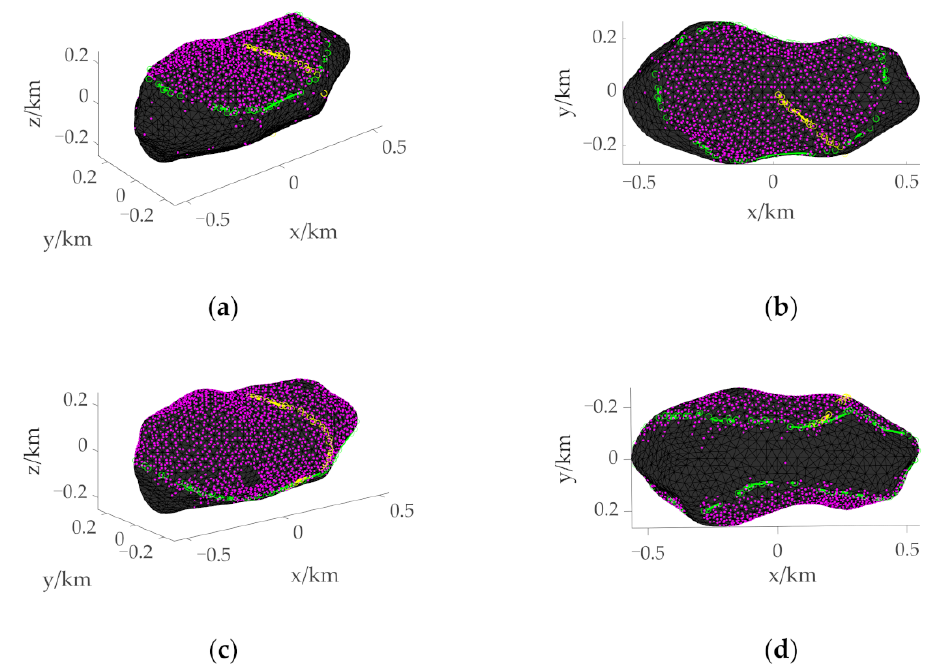
Figure 8. Initial boundary when the initial position is above the North Pole. ( a ) 3D view of the initial boundary with t f = 900 s. ( b ) Supplementary view of the initial boundary with t f = 900 s. ( c ) 3D view of the initial boundary with t f = 1000 s. ( d ) Supplementary view of the initial boundary with t f = 1000 s. The yellow “o” stand for points with feasible solutions between parallel planes. The green “o” stand for points that make up the initial boundary. The purple dots indicate the points with feasible solutions on the asteroid surface.